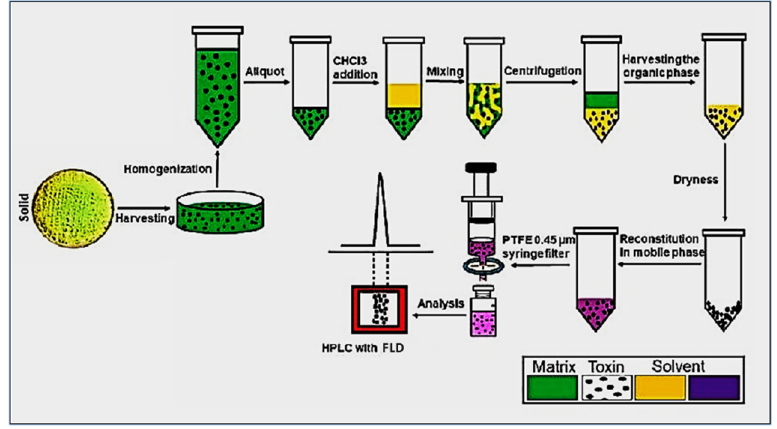
Figure 2. Flowchart showing the extraction of AFs from an A. flavus culture.